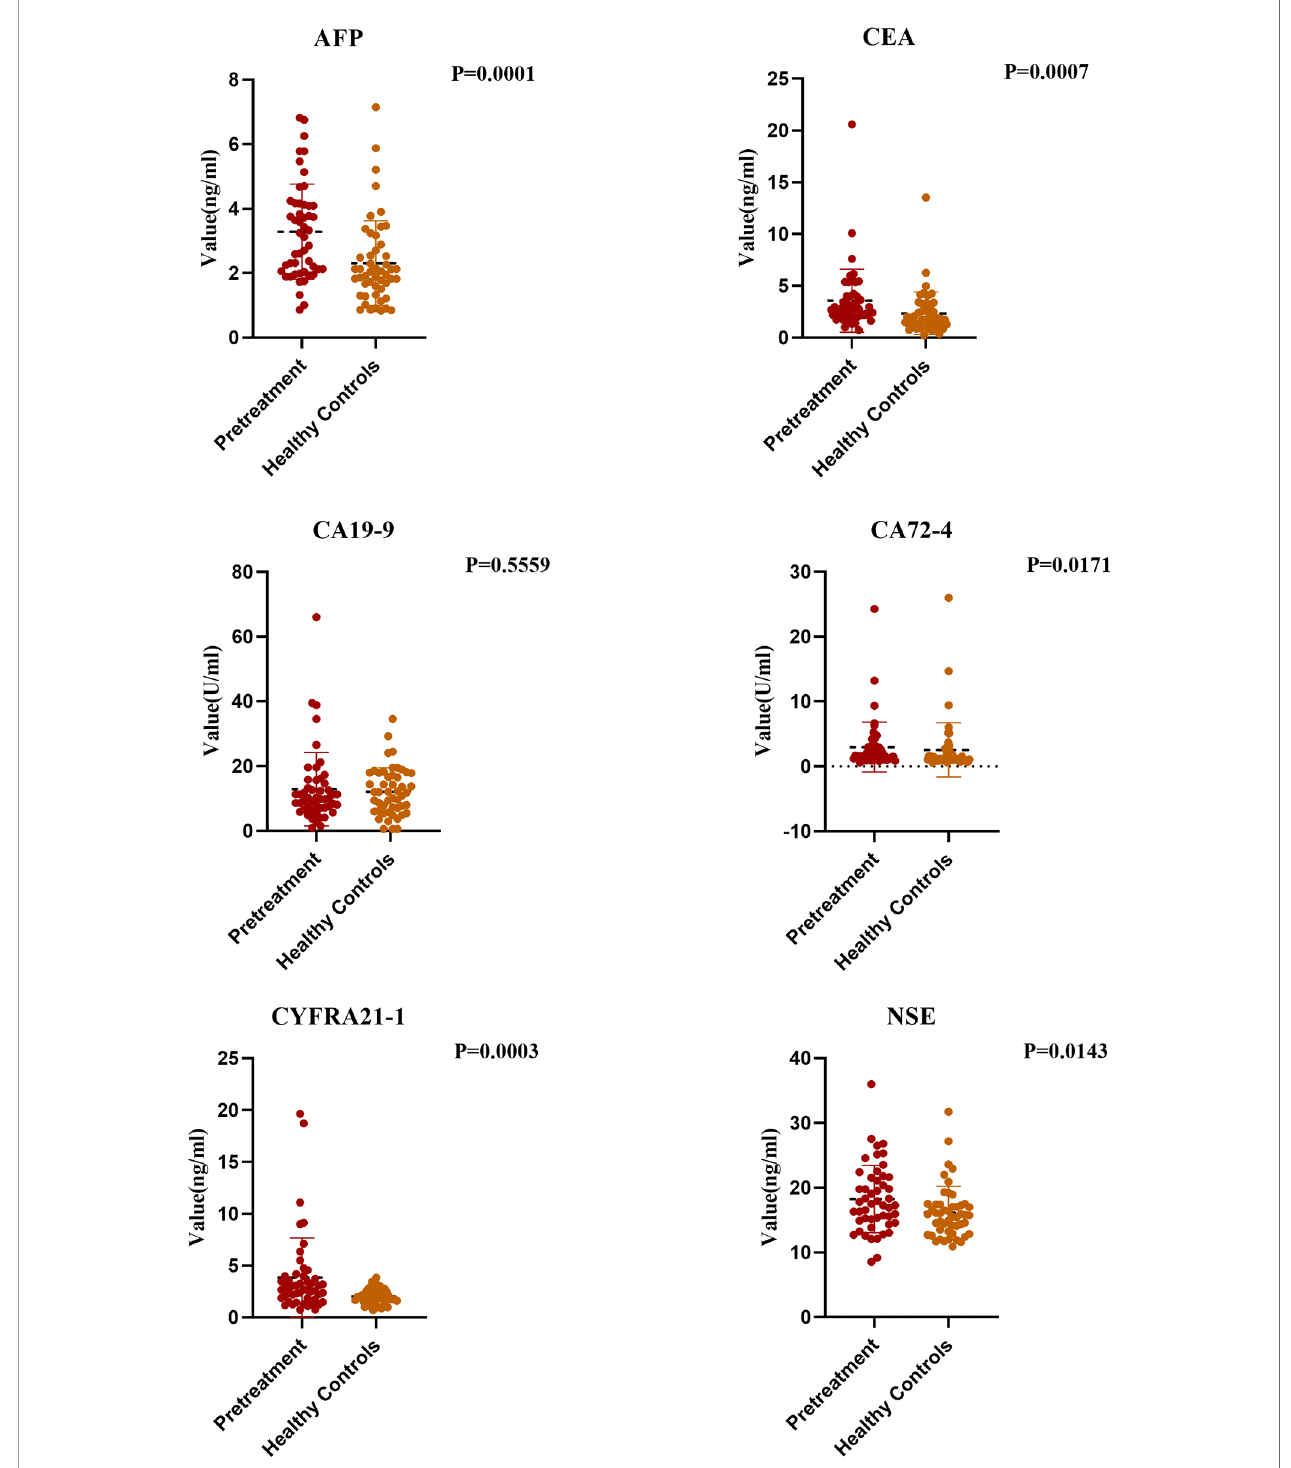
FIGURE 1 | Comparison of Tumor Markers between Pretreatment Group and Healthy